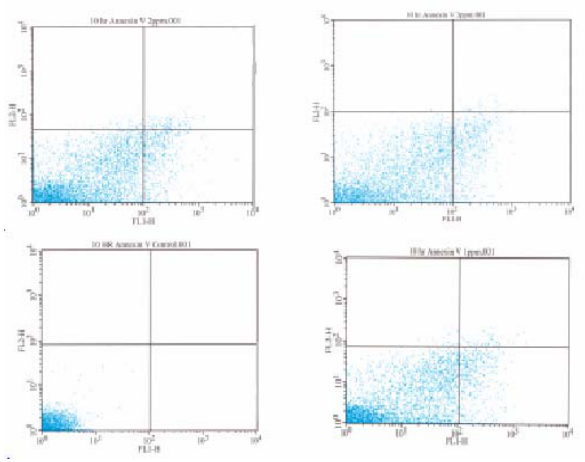
Figure 1: Flow cytometric analysis of Annexin-V cells exposed to mercury activity in HepG 2